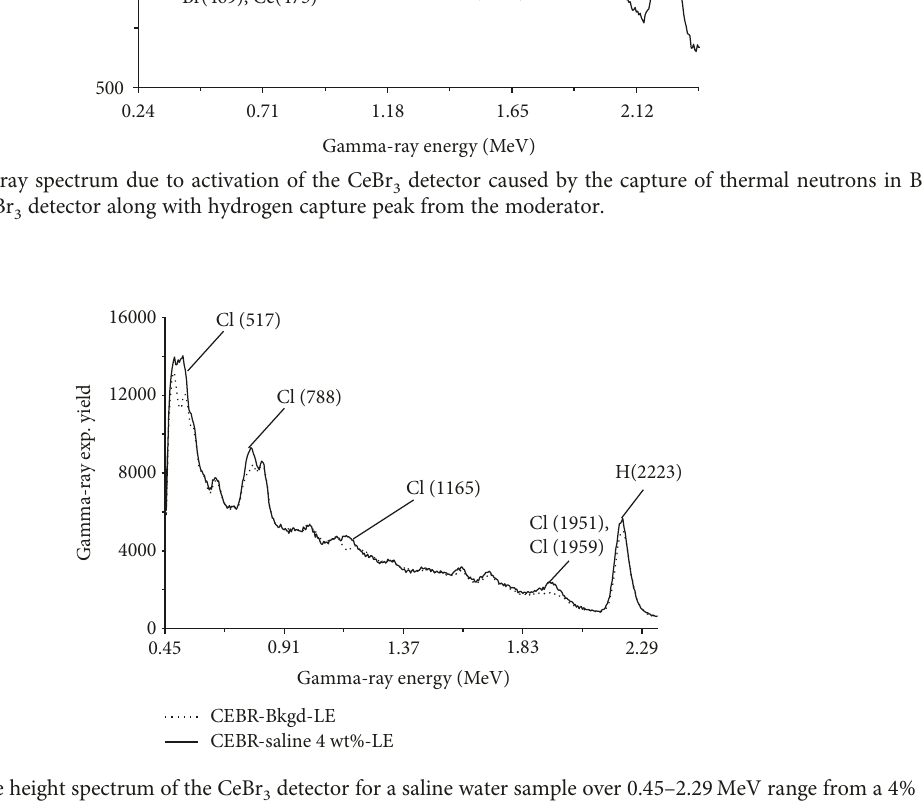
detector for a saline water sample over 0.45 – 2.29MeV range from a 4% chlorine- 3